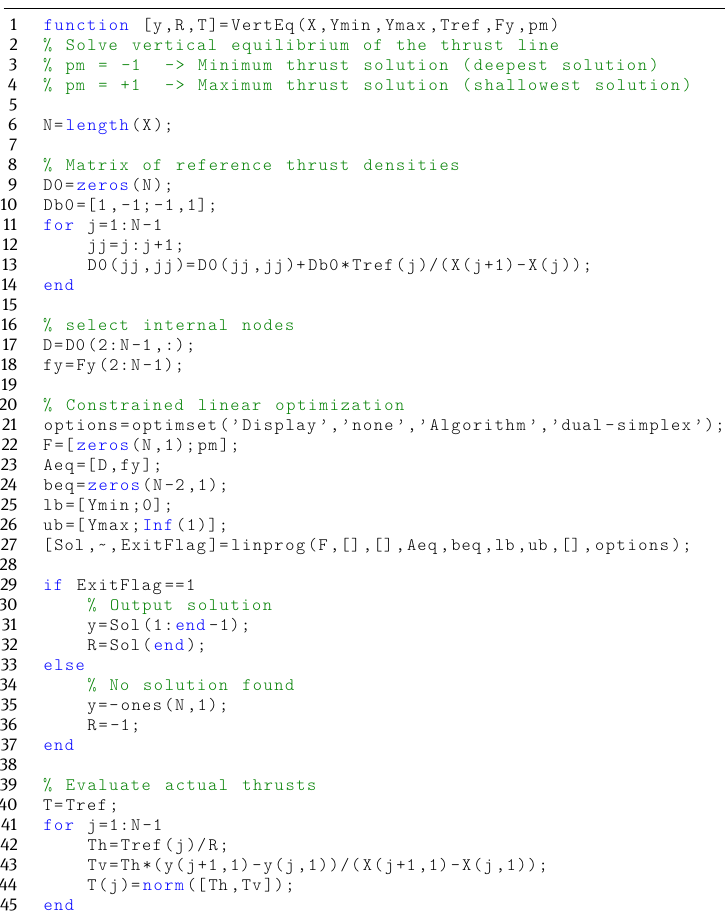
is obtained by assembling the contribution of each branch, that